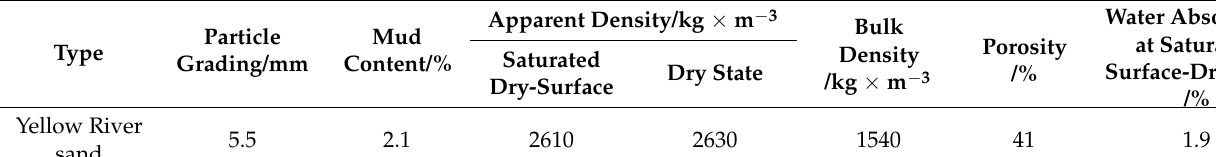
Table 5. XRF analysis results. Table 4. Physical properties of Yellow River sand.